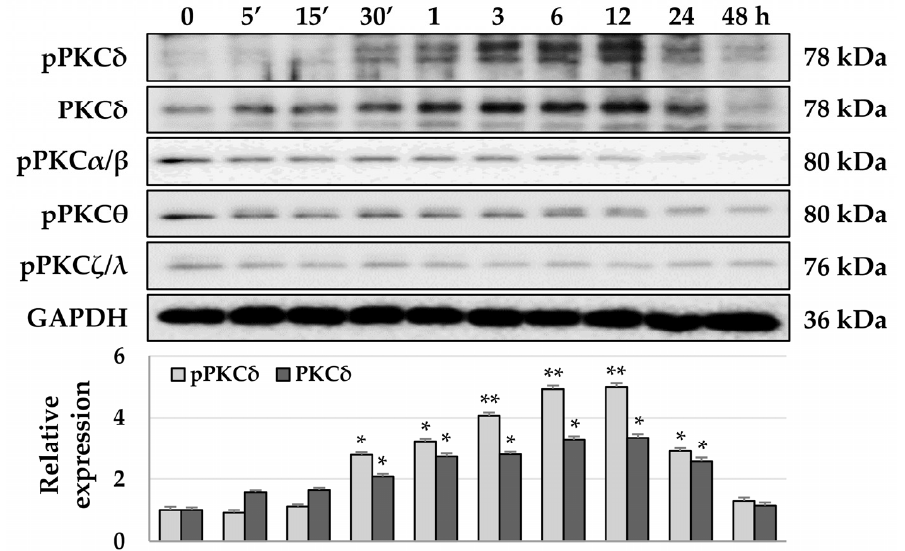
Figure 2. Phosphorylation of PKCs in TPA-treated LX-2 cells. LX-2 cells were treated with 10 nM TPA for the indicated time, and PKC phosphorylation was detected using the phospho-PKC antibody sampler kit (cell signaling technology). As only the phosphorylation of PKC δ was increased in TPA-treated LX-2 cells, we further confirmed the expression of total PKC δ . The intensity of protein expression was quantified using densitometry with Image J and its relative expression was normalized against that of GAPDH. Data are presented as the mean ± SD of three independent experiments. * p ≤ 0.05 and ** p ≤ 0.01.